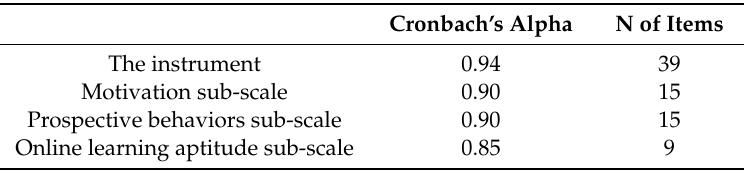
Table 2. The reliability of the instrument and its